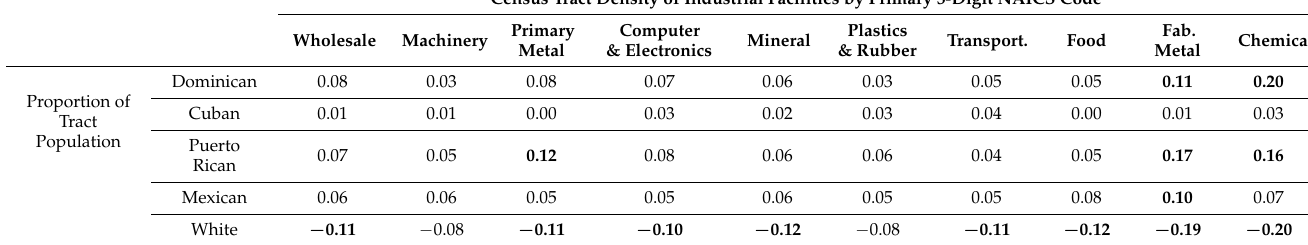
Table 2. Pearson correlations between census tract population of Latine groups, and the density of USEPA regulated facilities organized by their primary three-digit North American industry classification system.